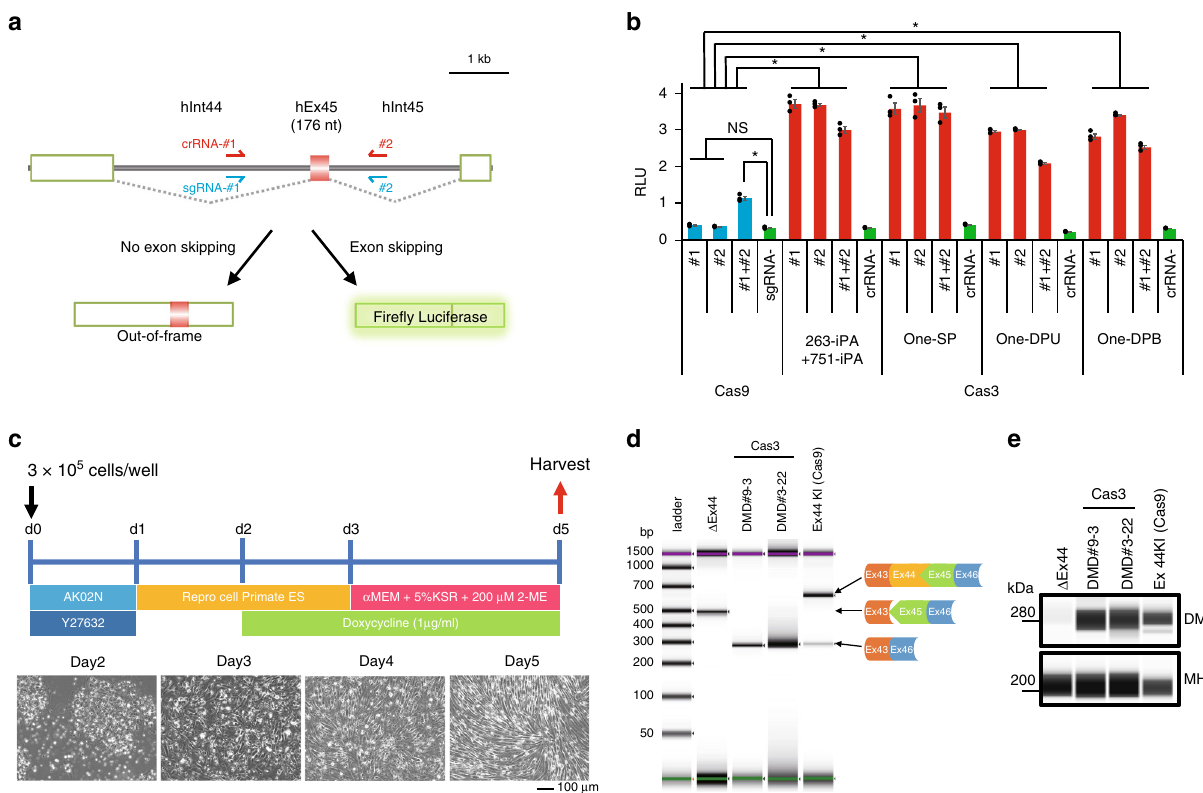
Fig. 4 Cas3-mediated DMD exon skipping in induced pluripotent stem cells. a Schematic of Cas3 (red)- or Cas9 (blue)-mediated DMD exon skipping by the luciferase reporter assay. b Ef fi ciency of the DMD exon skipping in 293 T cells by polycistronic plasmid vectors expressing CRISPR-Cas3 (see Supplementary Fig. 17a). Data are shown as mean ± s.e.m * P < 0.05, ANOVA with post-hoc Tukey test. c Scheme of skeletal muscle cell differentiation from iPSCs by doxycycline (Dox)-induced MYOD1 expression. bar indicates 100 µ m. d RT-PCR analysis of the DMD exon 45 skipping in skeletal muscle cells differentiated from subclones of DMD patient-derived iPSCs treated with Cas3 (#3-22 and #9-3). The iPSC line Ex44 KI is a control line previously generated by the insertion of Exon 44 in front of Exon 45 using SpCas9 52 . e The restored DMD protein detected by using Wes ProteinSimple in skeletal muscle cells differentiated from the exon skipping subclones of DMD-iPSCs. The iPSC line Ex44 KI was used as a positive control. Source data are in the Source Data fi